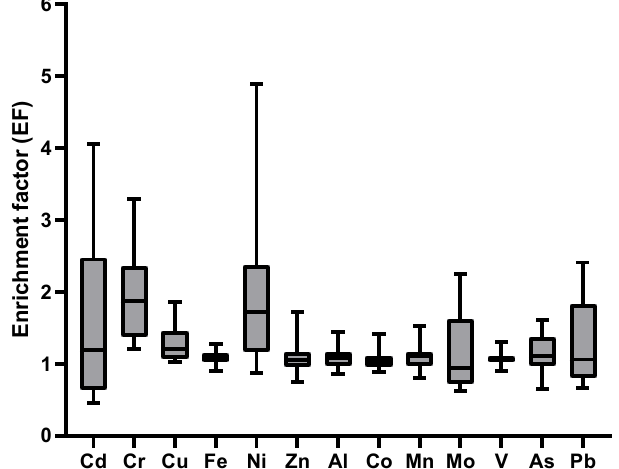
Figure 2. Box plot of the enrichment factor for studied PTE in agricultural soils.